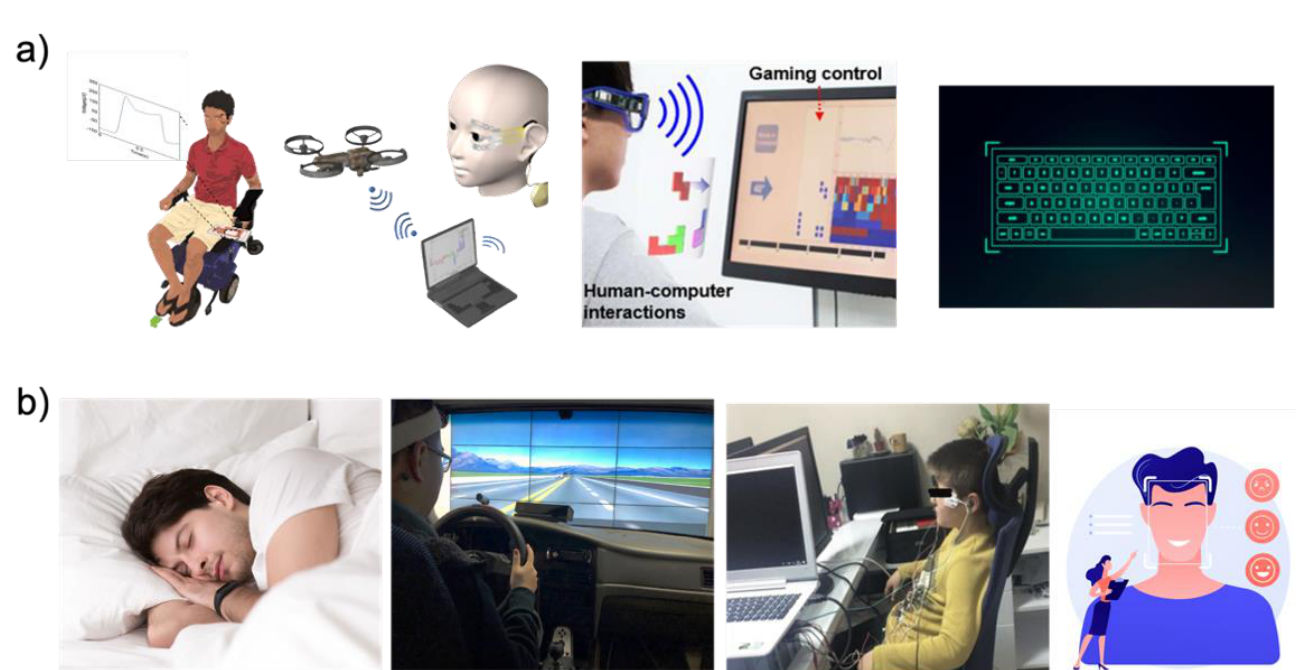
Figure 10. ( a ) Controller-type applications such as wheelchairs, drones, game interfaces, and virtual